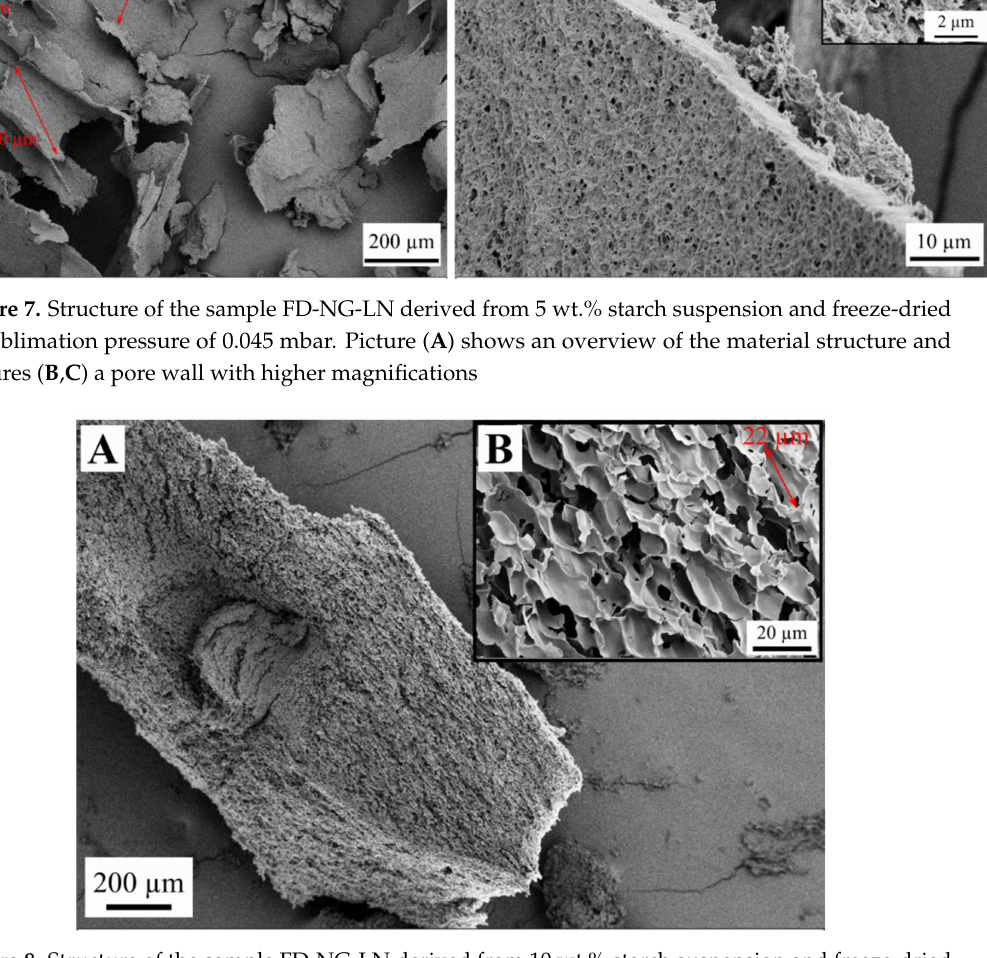
Figure 8. Structure of the sample FD-NG-LN derived from 10 wt.% starch suspension and freeze-dried at sublimation pressure of 0.045 mbar. Picture ( A ) shows an overview of the material which fine structure is displayed with a higher magnification on picture ( B